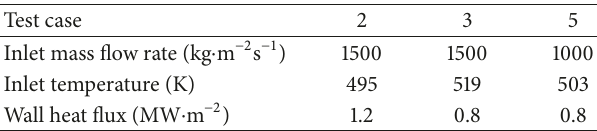
Table 6: Experimental conditions retained for Bartolomei experi-